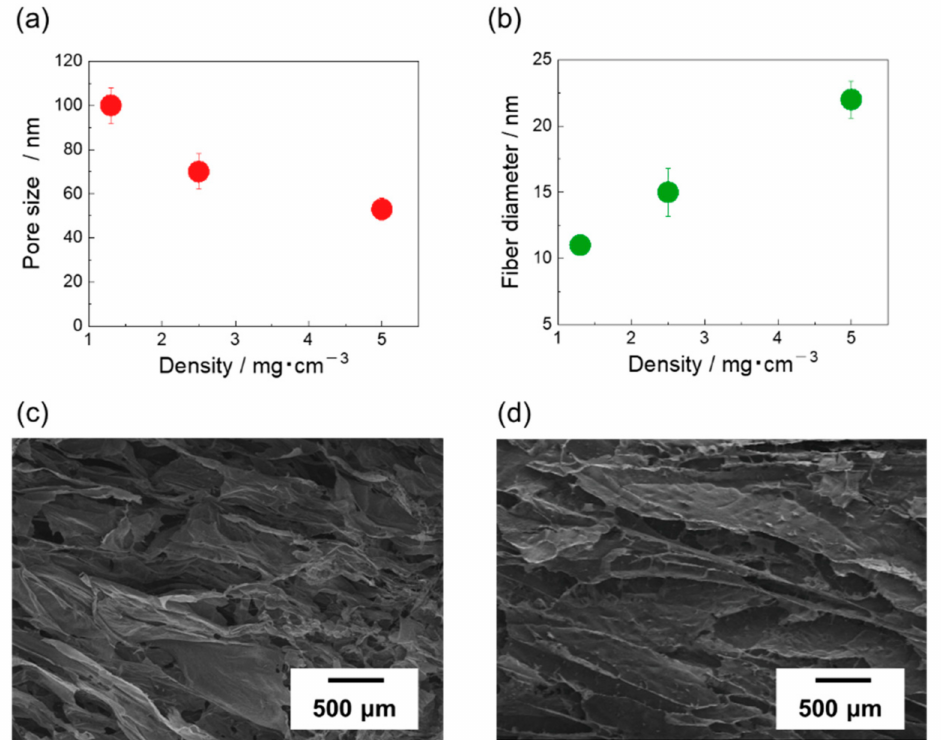
Figure 3. ( a ) Pore size versus density. ( b ) Fiber diameter versus density. ( c ) SEM images of the wall in CNT/CMC2(1.3_10) sponge. ( d ) SEM images of the wall in CNT/CMC2(5_10)